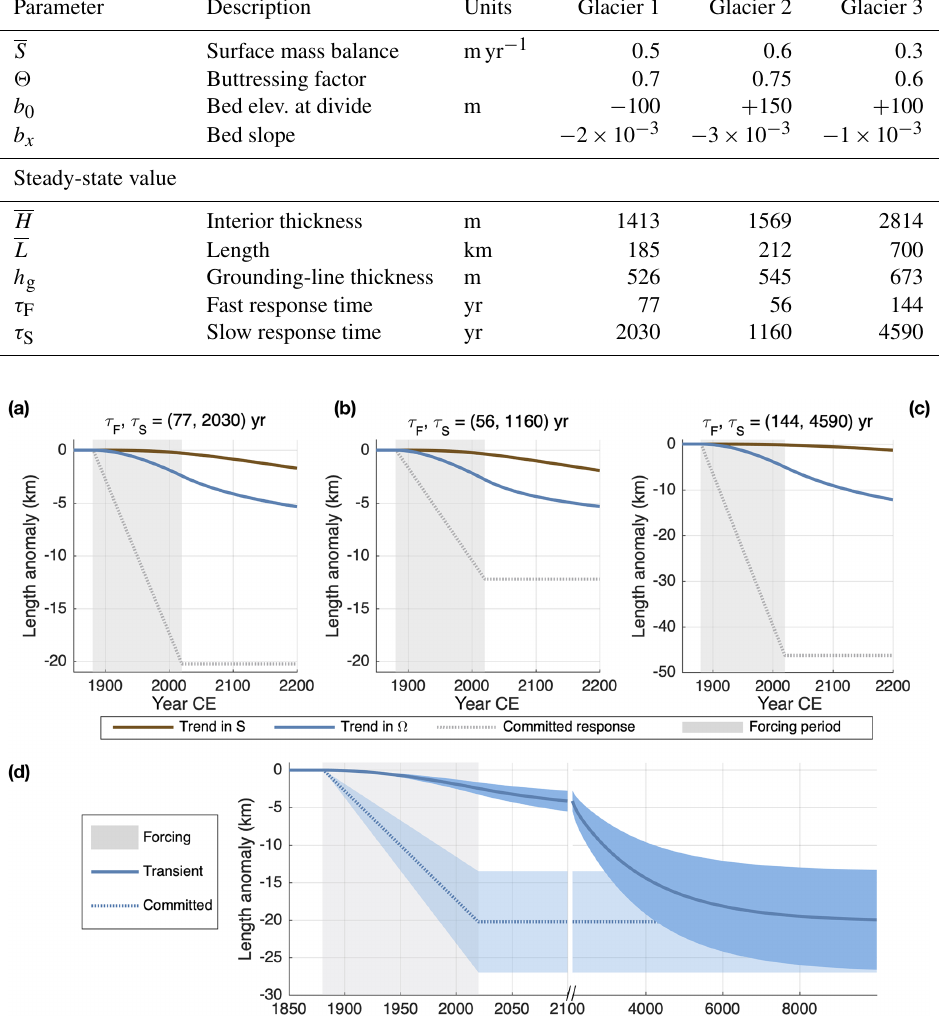
Figure 5. Glacier responses to idealized climate forcing over the industrial era. (a) Responses for glacier 1 (see Table 2). A 30% change in S (brown) or (cid:127) (blue) is realized as a linear trend from 1880 to 2020CE. Dotted lines show the grounding-line position that would balance accumulation and grounding-line fluxes. (b) As for (a) but for glacier 2, which has faster response times and smaller equilibrium sensitivity. (c) As for (a) and (b) , for glacier 3, which has slower response times and greater equilibrium sensitivity. (d) The range of responses of glacier 1 due to an uncertain forcing, idealized as a trend in (cid:127) reaching a 20%–40% change by 2020. The slow transient response means a small range in absolute length change in the modern era, but uncertainty in the forcing projects directly onto the committed equilibrium response. Note the break in the time-axis scale at